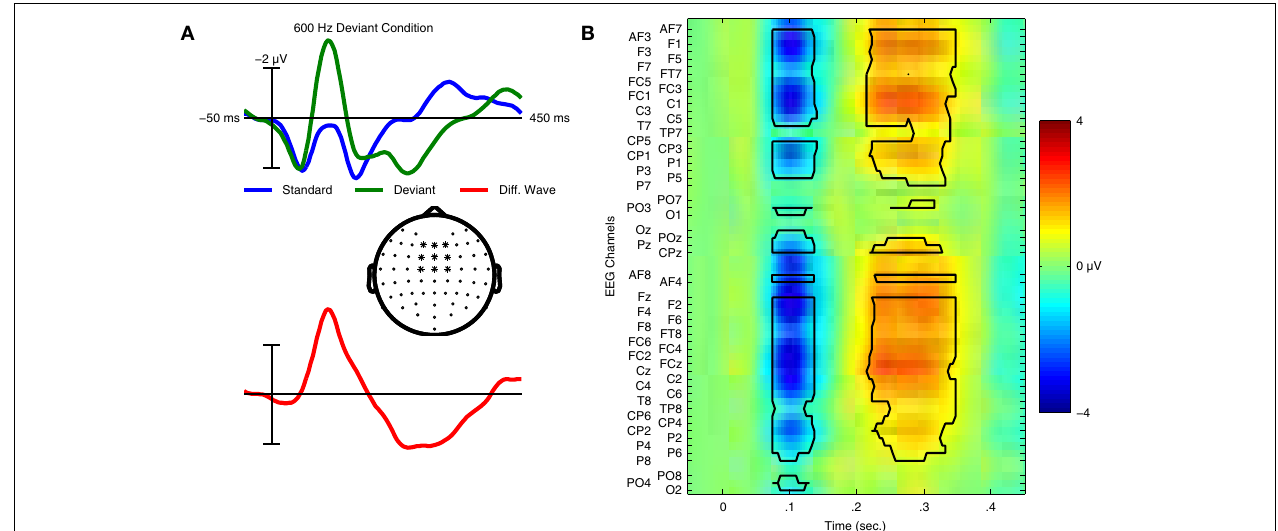
FIGURE 1 | Grand average ERPs and statistical analysis for Dataset 1. (A) Grand average ERPs of 14 participants in Dataset 1 for both standard and deviant trials are shown with the deviant minus standard difference wave used to quantify the mismatch negativity response. ERPs were calculated using the average of 9 fronto-central electrode locations (indicated in the scalp map) where the MMN response is typically maximal in amplitude. Relative to the ERP for the standard trials, the deviant ERP shows an enhancement of the negative peak in the N1 time window and an additional positivity between 200 and 300ms relative to stimulus onset. This component is referred to as the P3a, and is elicited in MMN paradigms that